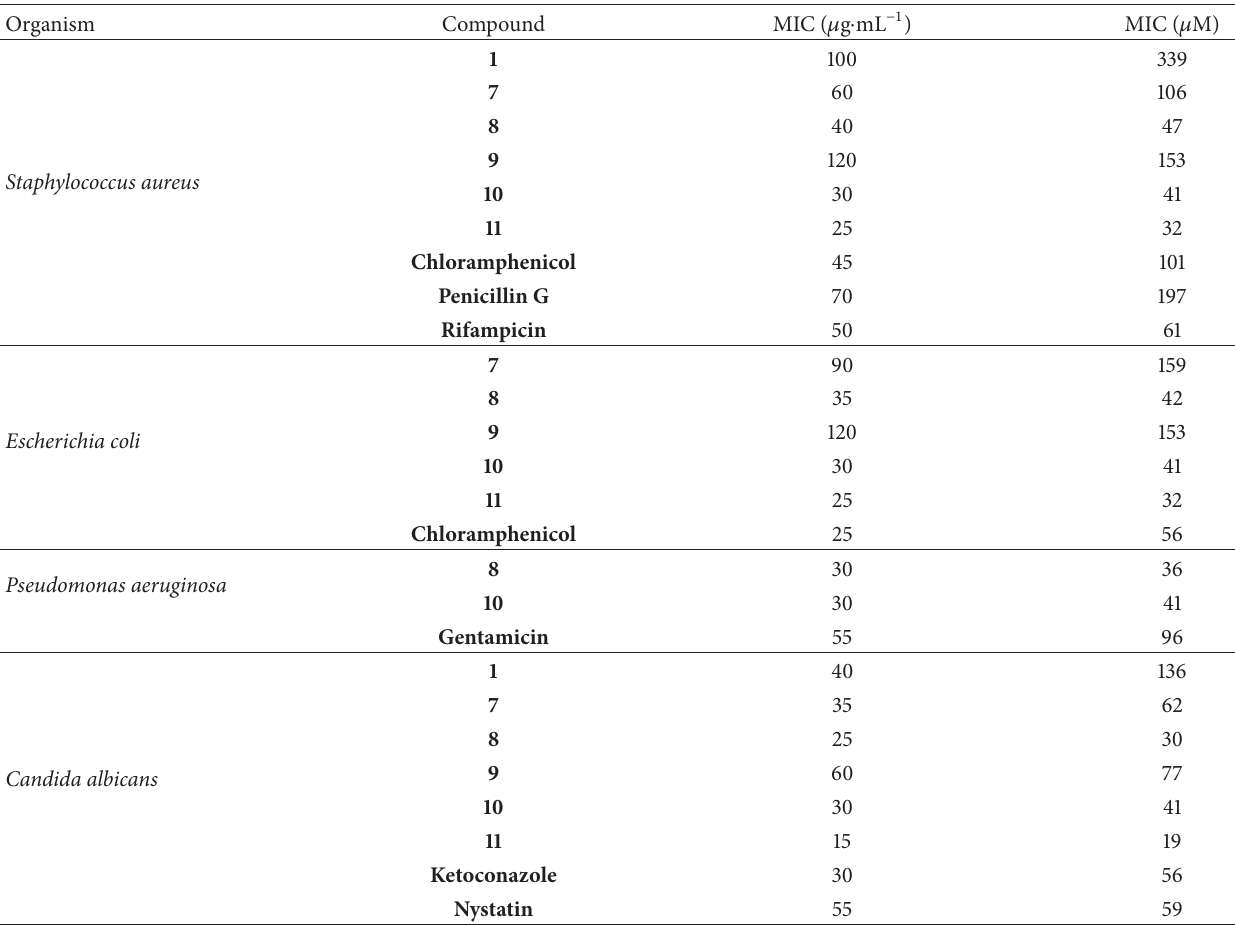
Table 2: Minimum inhibitory concentration (MIC) of selected